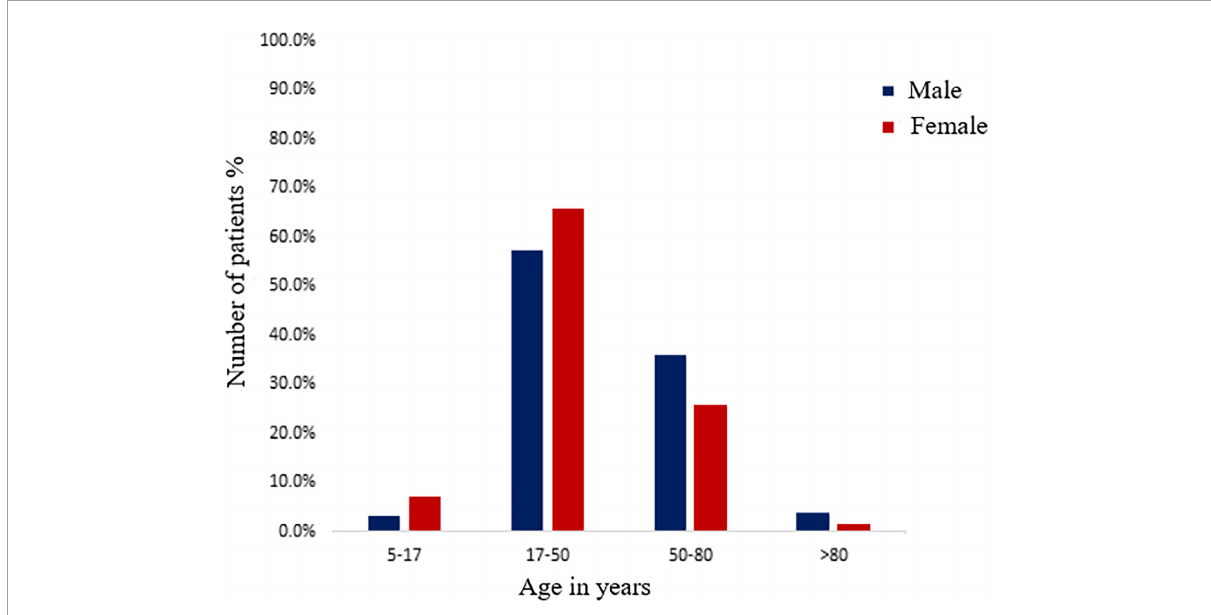
FIGURE1 Distribution of male and female positive urinary tract infection (UTI) patients among different age